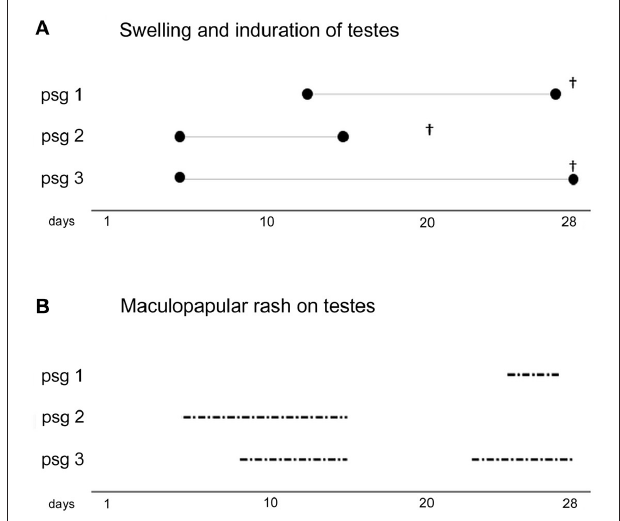
FIGURE 2 | The course of infection in three experimental rabbits inoculated intratesticularly with the TPeC Cz-2020 strain. The cultivation of TPeC Cz-2020 was achieved in three passages (psg), all of which resulted in swelling and induration of the testes and in the appearance of maculopapular rash on the infected testes. ( A , top) The duration (in days) of inflammation (i.e., swelling and induration of testes) are illustrated by the length of the three line segments delimited by • . The day of euthanasia of each animal is depicted by † . ( B , bottom) The duration of rash, for each passage, on scrotal skin is depicted by the dash-dot